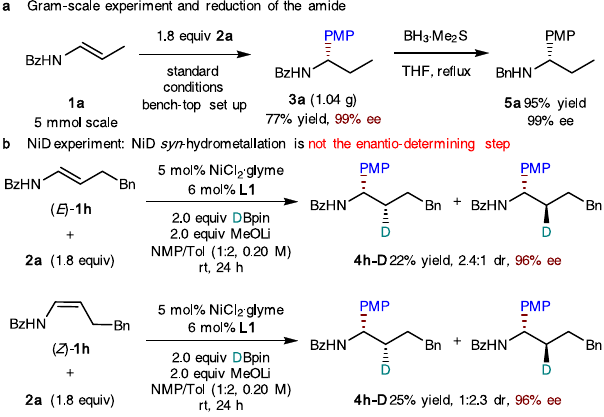
Fig. 5 Gram-scale, derivatization, and deuterium-labeling